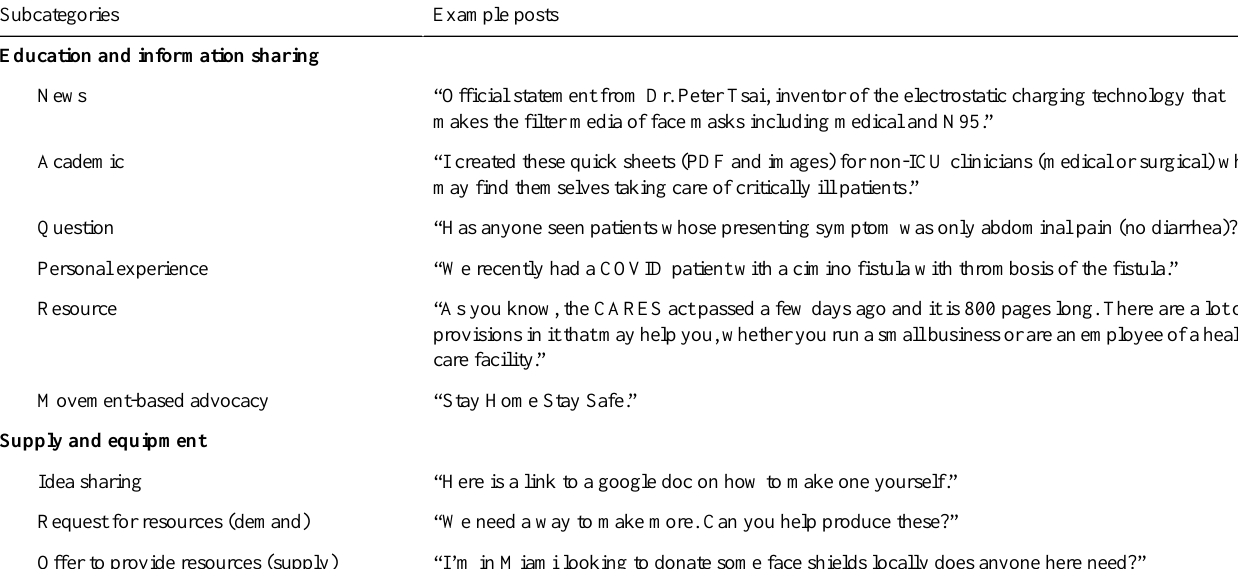
Table 1. Predetermined coding framework for post